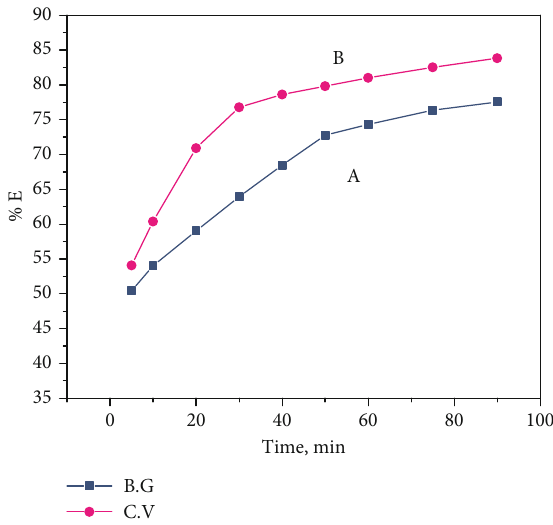
Figure 9: Impact of stirring time on the sorption percentage of dye species B.G. (a) and C.V. (b) from aqueous solutions to the binary P3NT/30%AgTiO NCs at 22 ° C temperature. NCs with 75 min 2 2